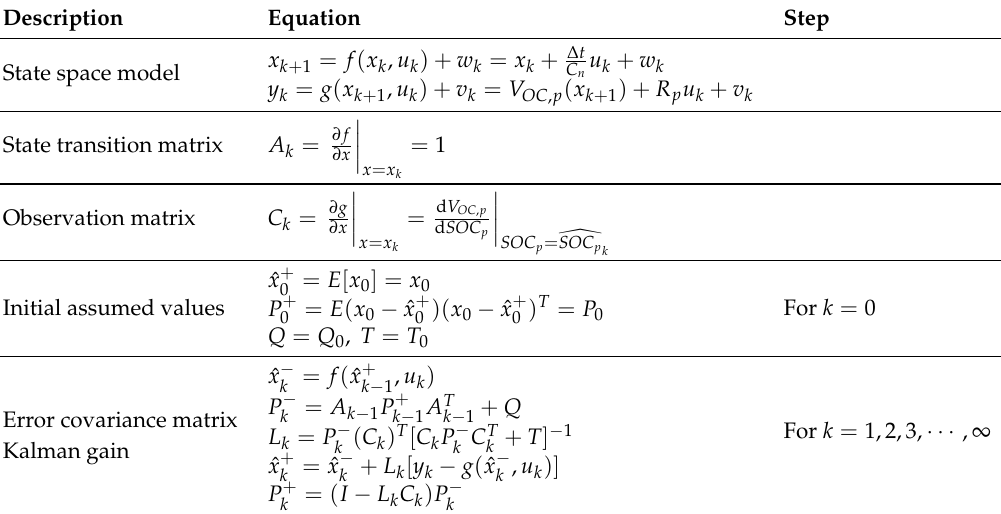
Table 1. Essential equations for estimating the SOC p in the extended Kalman filter (EKF)